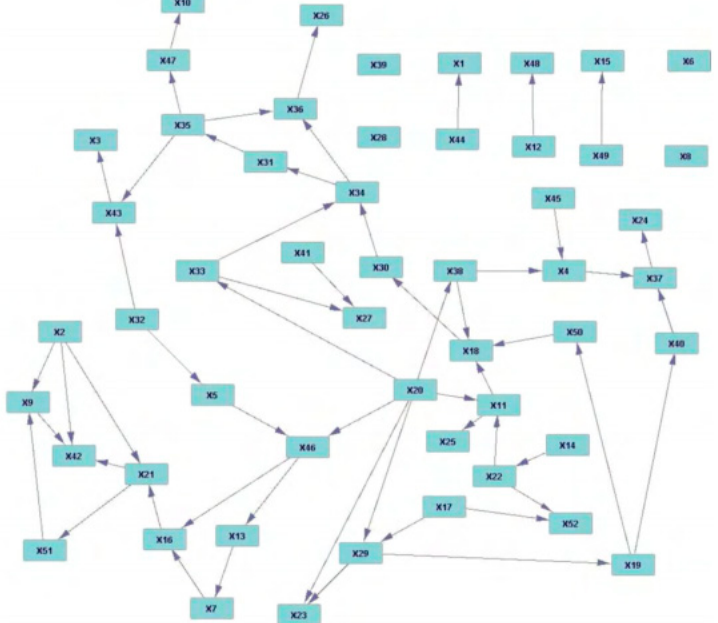
Figure 15. Causal Bayesian network of the TEP in Sylvain Verron’s study. Reproduced with permission from [Verron, S.; Li, J.; Tiplica, T.], [Journal of Process Control]; published by [Elsevier], 2010.